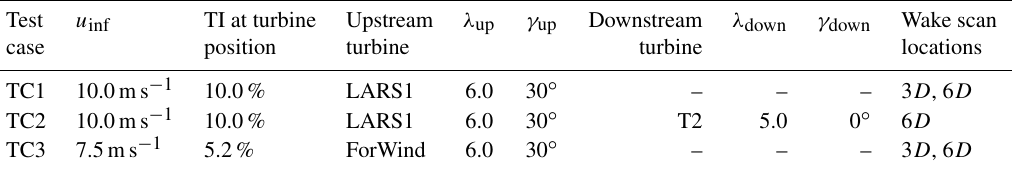
Table 1. Summary of the parameters that are varied for the three investigated test cases, up refers to the upstream and down to the downstream turbine